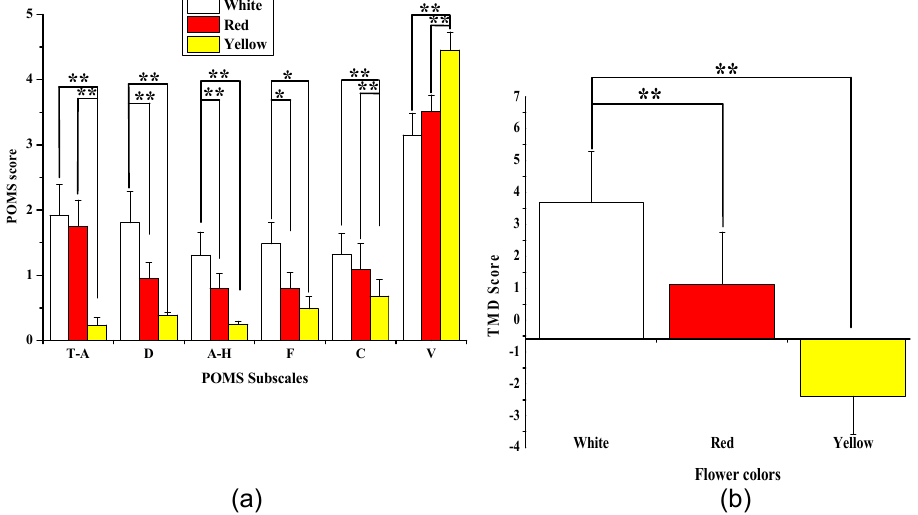
Figure 8. Subscale scores for the profile of mood states, tension/anxiety (T-A), depression/dejection (D), anger/hostility (A-H), fatigue (F), confusion (C), and vigor (V) after the visual stimulation with white, red, and yellow flowers ( a ); total mood disturbance (TMD) score (b) . * p < 0.05, ** p < 0.01 using the Wilcoxon signed-rank test.